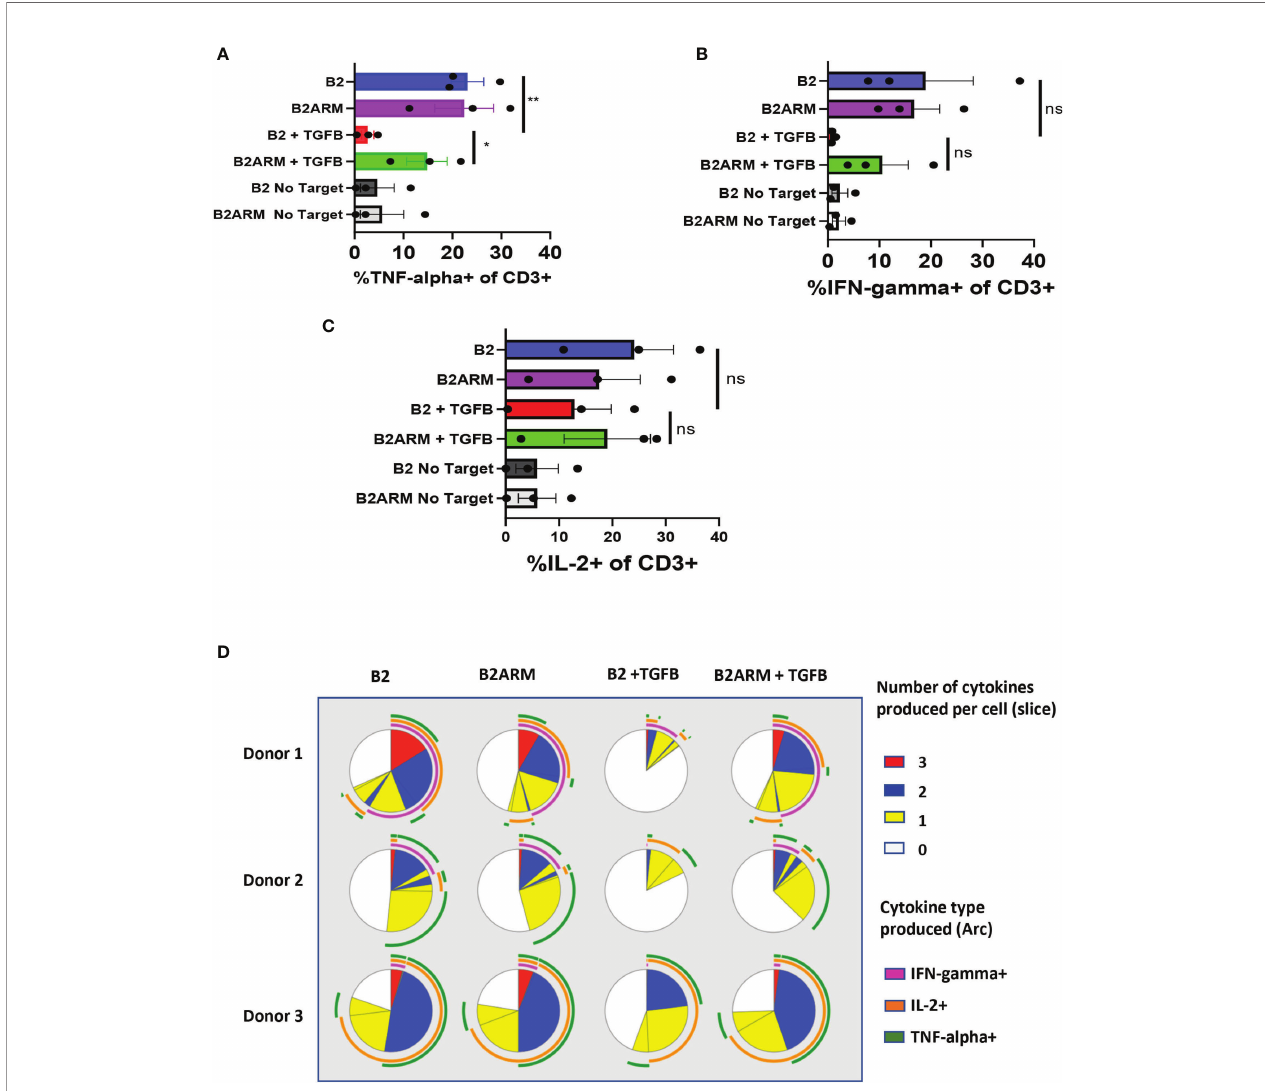
FIGURE 5 | The B2ARM CAR attenuates the suppression of cytokine responses and maintains polyfunctionality after prolonged exposure to TGF- b . Cytokine production in CD3+ cells was determined by intracellular staining and fl ow cytometry analysis on day 8-10 after the start of co-culture with MM.1S cells for (A) TNF- a , (B) IFN- g , and (C) IL-2. Co-cultured cells were incubated at 37°C degrees for 5 hours in the presence of brefeldin (A) N=3 separate donors, mean ± SEM. *p<0.05, **p<0.01. (D) Combinatorial gating function in Flow Jo software and SPICE analysis were utilized to determine the ability of individual cells to produce multiple cytokines during long-term co-culture with MM.1S cells. Results from T cells from three separate donors are shown in rows. Each pie chart represents one treatment group. Slices within the chart represent fractions of the total T cell population organized based on the number of cytokines, which T cells contained in that fraction produced in response to treatment (white-0, yellow-1, blue-2, red-3). Arcs on the outside of the pie chart signify which cytokine(s) were produced by T cells denoted within the corresponding slice of the pie chart (magenta-IFN- g , green-TNF- a , orange-IL2), ns-non-speci fi